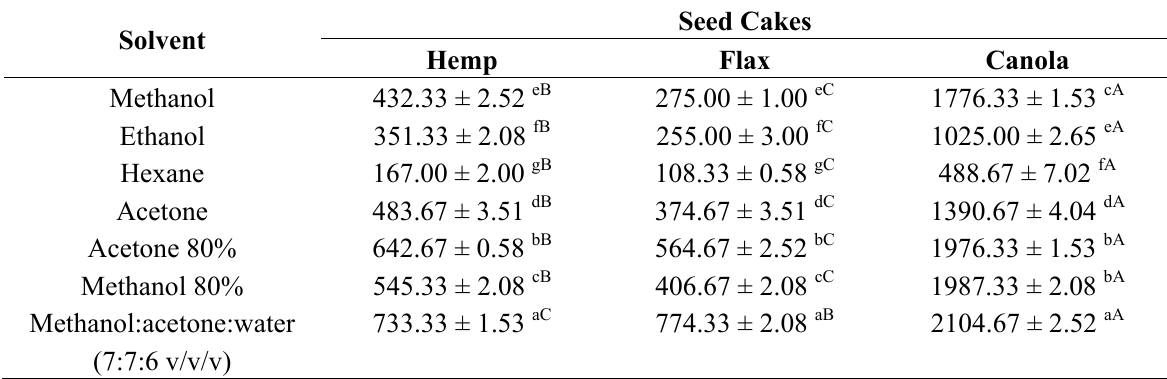
Table 1. Total phenolic content (mg GAE/100 g fresh weight).